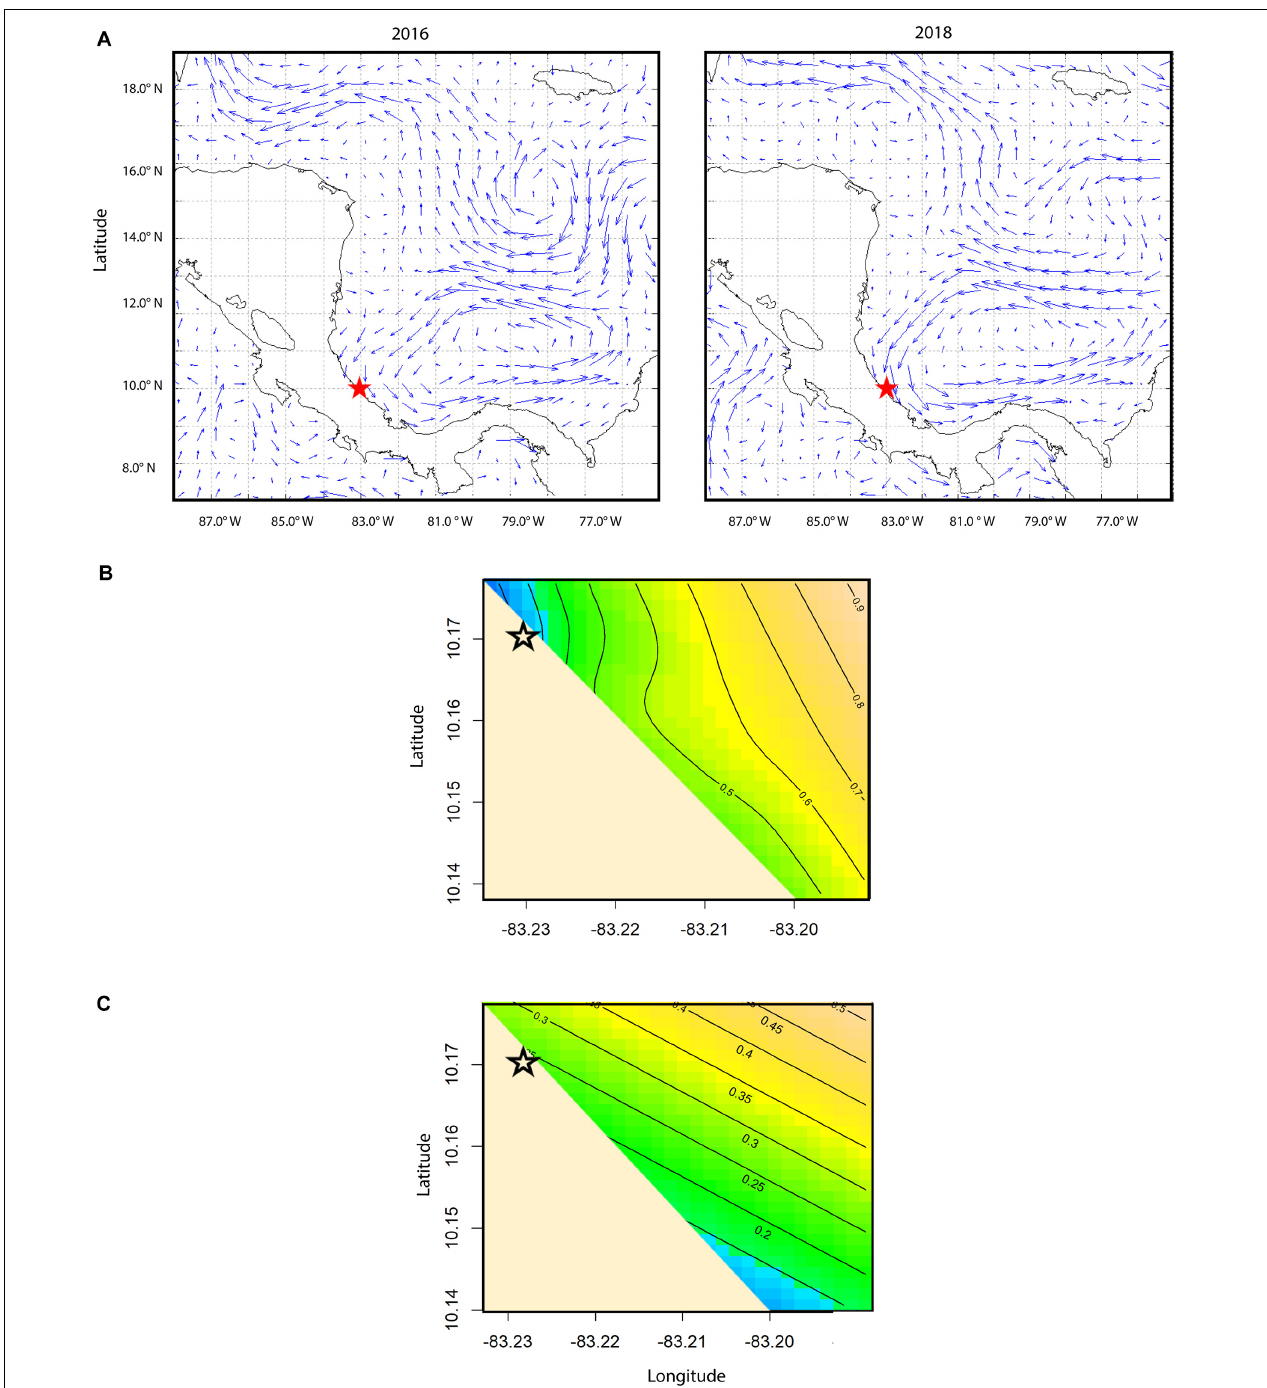
FIGURE 3 | (A) Plot of delayed mode absolute geostrophic current velocity vectors with the study site in Pacuare, Costa Rica (red star). Plot on the left is for the week of August 8th, 2016, and plot on the right is for the week of August 6th, 2018. Mean velocity was 0.665 m s − 1 for this time period in 2018 and 0.552 m s − 1 for this time period in 2016. Plots were created using the AVISO + satellite altimetry data Live Access Server (LAS). (B) Spatial contour plot of the raw track speed of the current, with higher values shown in yellow and lower values shown in blue. Black lines show contours of current speed as output from a generalized additive mixed model predicting current speed as a function of year and smoothed interaction of latitude and longitude. (C) Spatial contour plot of neonate true speed (m s − 1 ), with higher values shown in yellow and lower values shown in blue. Black lines show contours of true neonate swimming speed as output from a generalized additive mixed model predicting neonate true swimming speed as a function of year, current speed (m s − 1 ), first passage time, and the smoothed interaction of latitude and longitude.